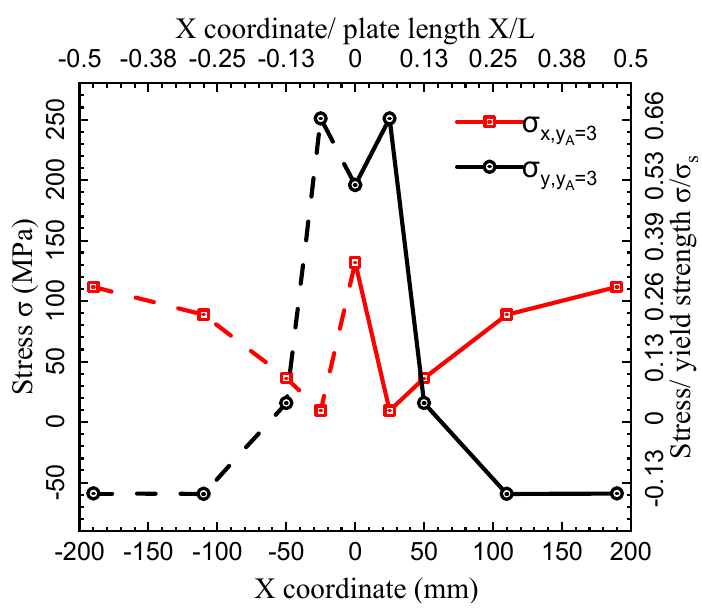
. (cid:3052) (cid:3250) (cid:2880)(cid:2871)